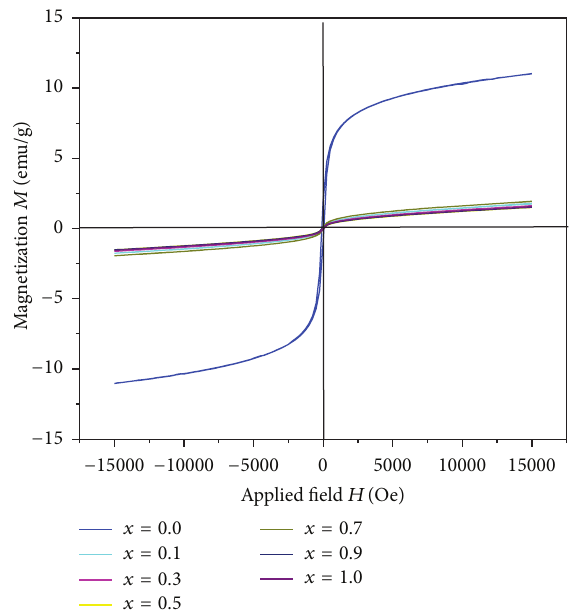
Figure 1: M - H curves for MgCr 𝑥 Fe 2−𝑥 O 4 (𝑥 = 0.0, 0.1, 0.3, 0.5, 0.7, 0.9, and 1.0) nanoparticles synthesized by Citrate-gel technique.